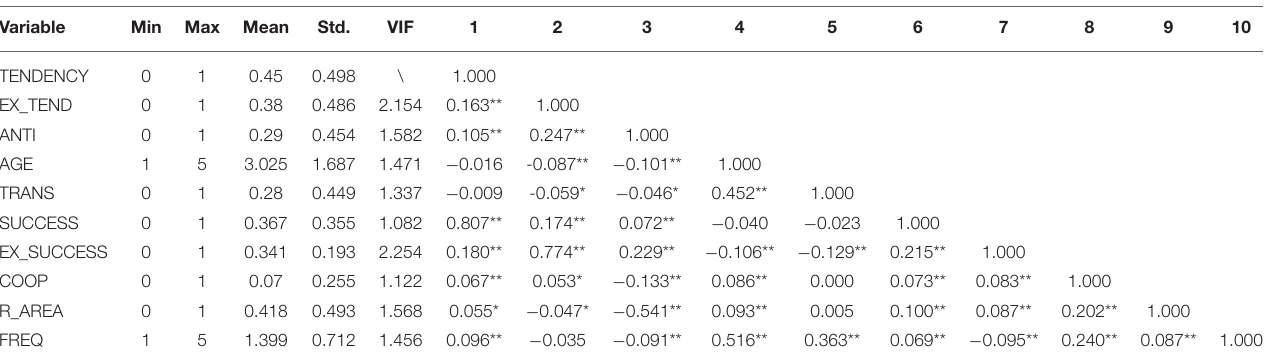
TABLE 3 | Descriptive statistics and multi-collinearity analysis of